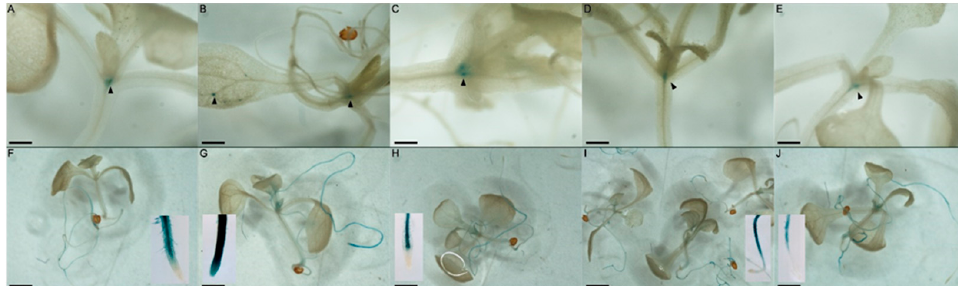
Figure 2. Cytokinins induce the ZmTCRR2promoter in Arabidopsis. Upper panels ( A – E ) show re- sults for the ZmTCRR1 promoter, and lower panels ( F – J ) display ZmTCRR2 promoter plants. seven- day-old plantlets were cultured for 24 h on 1 µM ACC ( A , F ), BA ( B , G ), IAA ( C , H ), gibberellic acid ( D , I ) or MS control plates ( E , J ), and then stained for GUS activity. Distained plants were photo- graphed to assess promoter activation qualitatively. For the ZmTCRR1 promoter, none of the treat- ments caused any observable change in staining, either in intensity or location. On the other hand, other hormonal activators did not cause significant changes under these culture conditions.